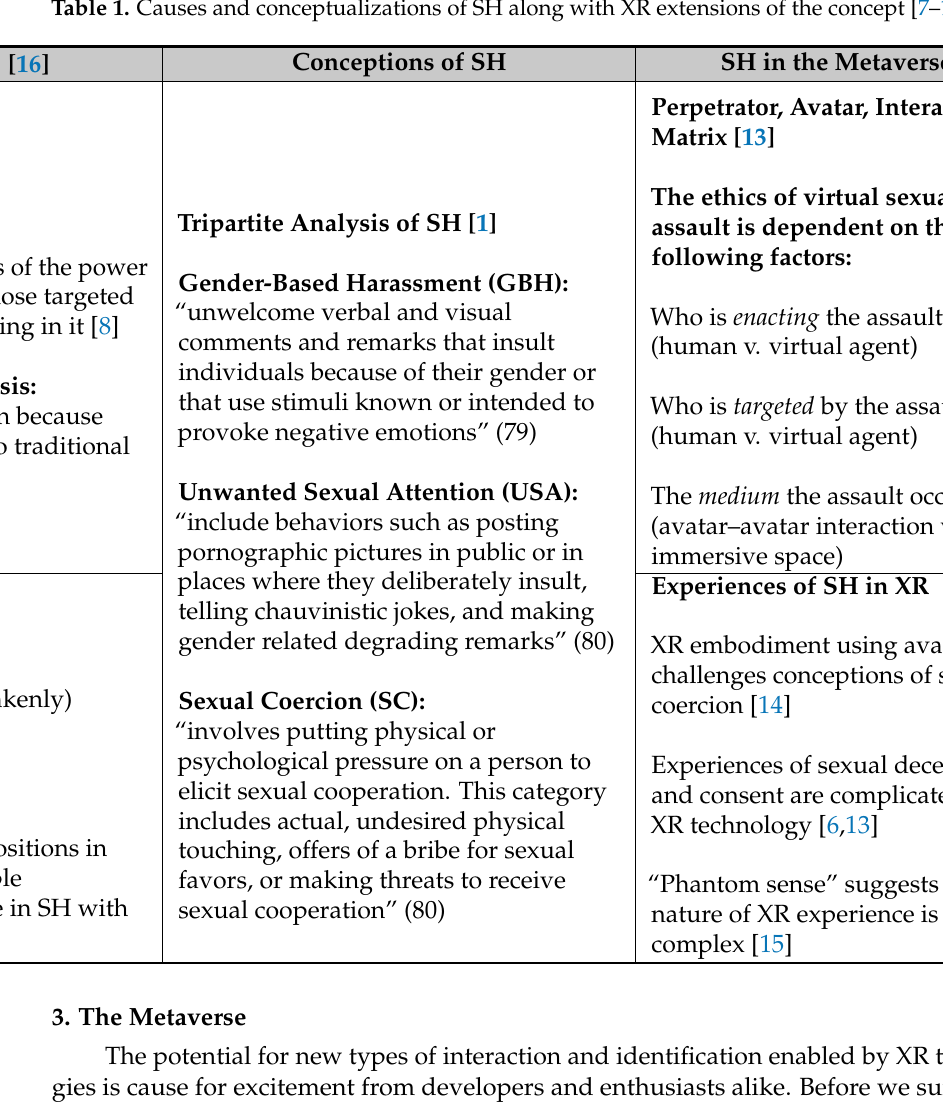
Table 1. Causes and conceptualizations of SH along with XR extensions of the concept